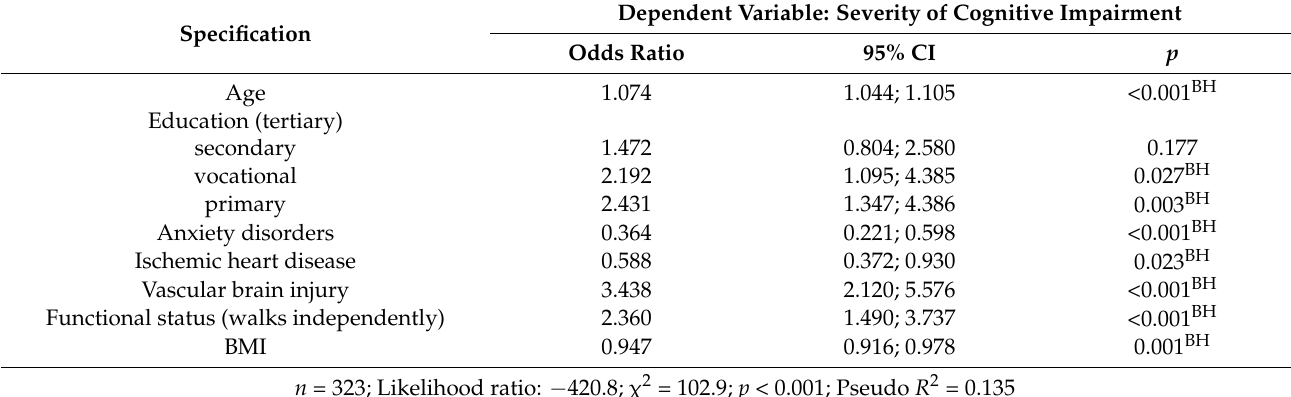
Table 5. Ordinal logistic regression results of model for factors related to severity of cognitive